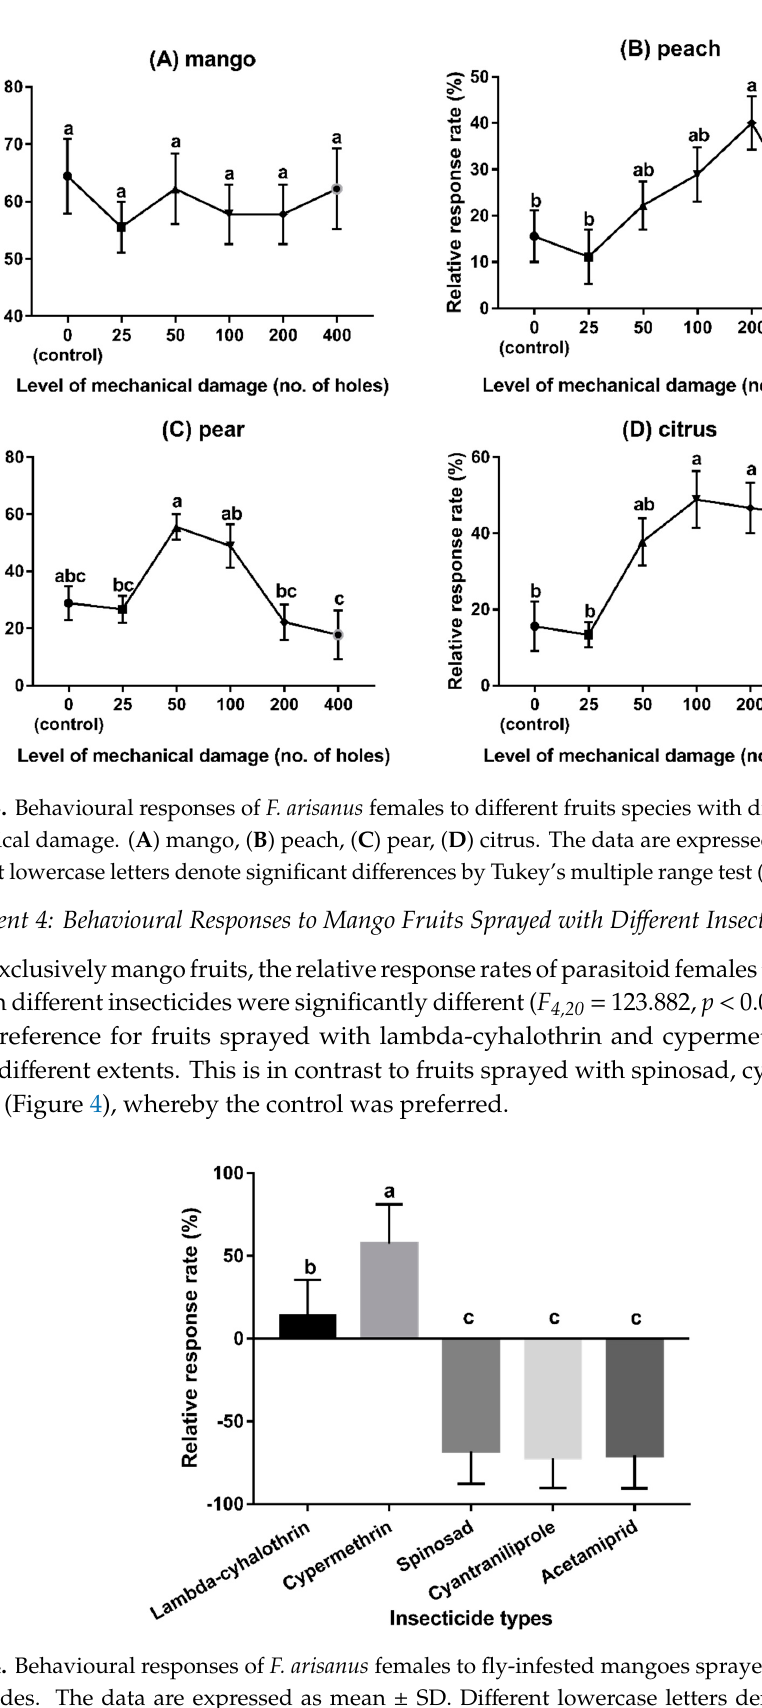
peaches with 200 punctures was significantly higher than to those with 0 or 25 punctures (Figure 3B,